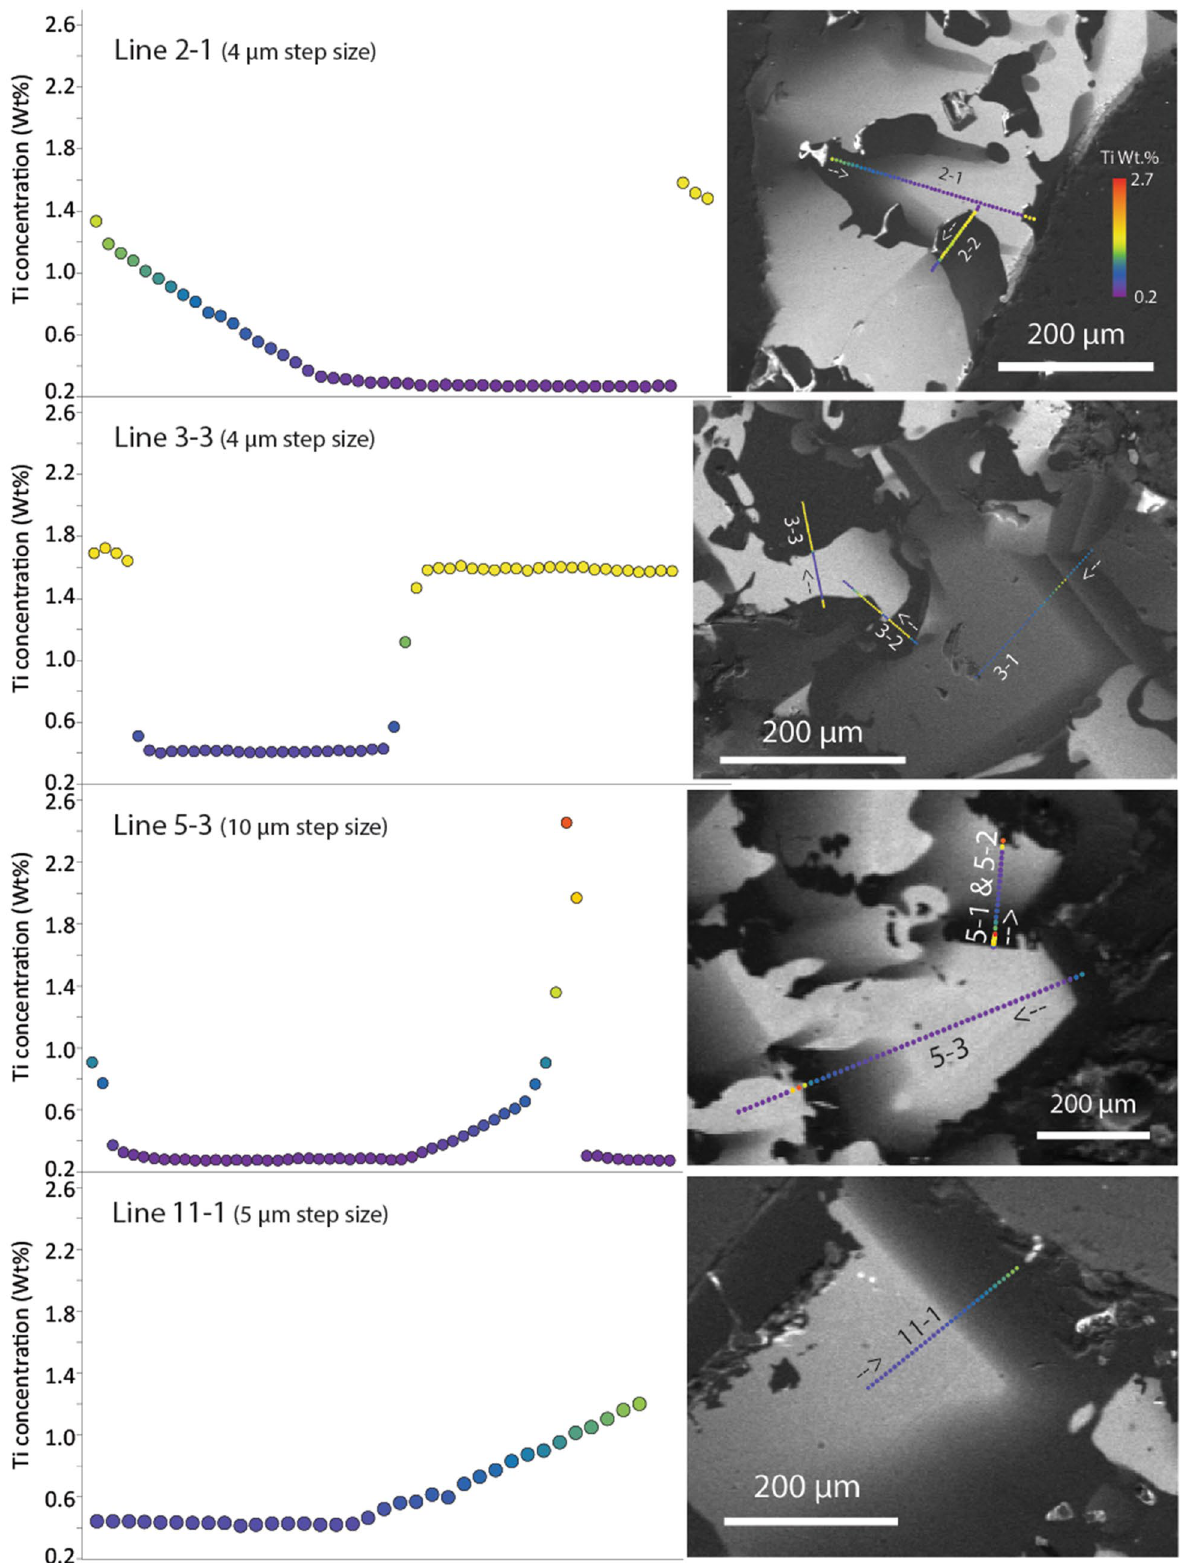
Figure 3. Montage of EMP traverses discussed in text, with CL images showing